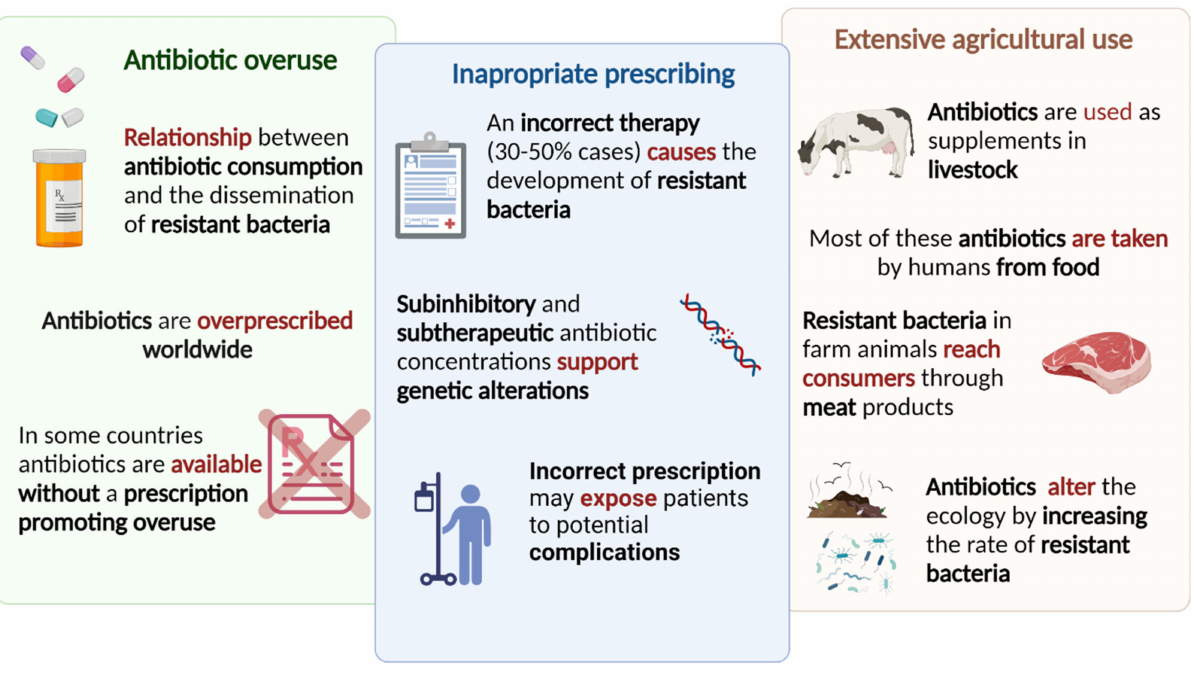
Figure 14. Summary of the roots of the antibiotic resistance crisis. Created with BioRender.com (Accessed on 29 April